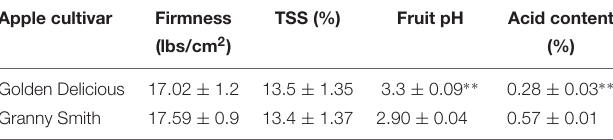
TABLE 2 | Fruit physiological parameters of two different